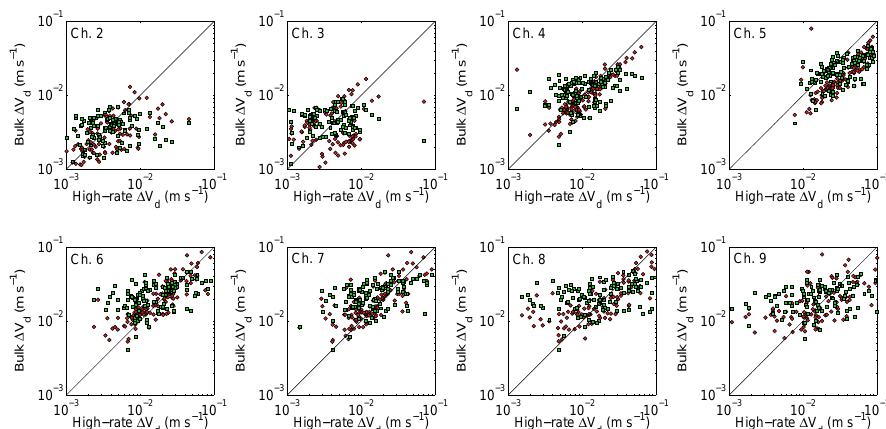
Fig. 10. Scatterplots showing the relationships between the high-rate 1v d and modified K01 (red) and F84 (green) 1v d in Fig. 9.